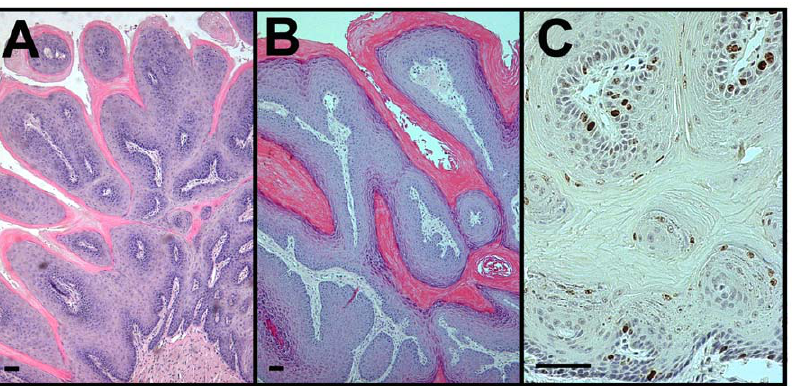
Figure 3. Kras G12D led to squamous papillomas in the oral cavity. A.H&E staining of papillomas on back of tongue. B. H&E staining of buccal papillomas. C. Immunolabeling for phosphohistone H3 (brown), an M phase marker, revealed that the proliferative zone in papillomas remained in the basal layer. Size bars, 50 m m.